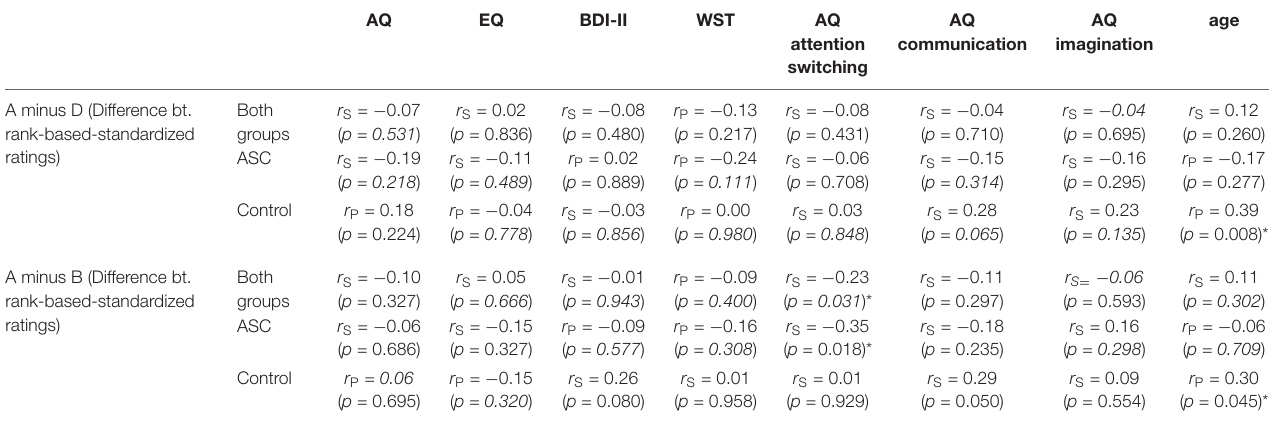
TABLE 3 | Correlations between psycho(pathological) measures and rating differences for compared